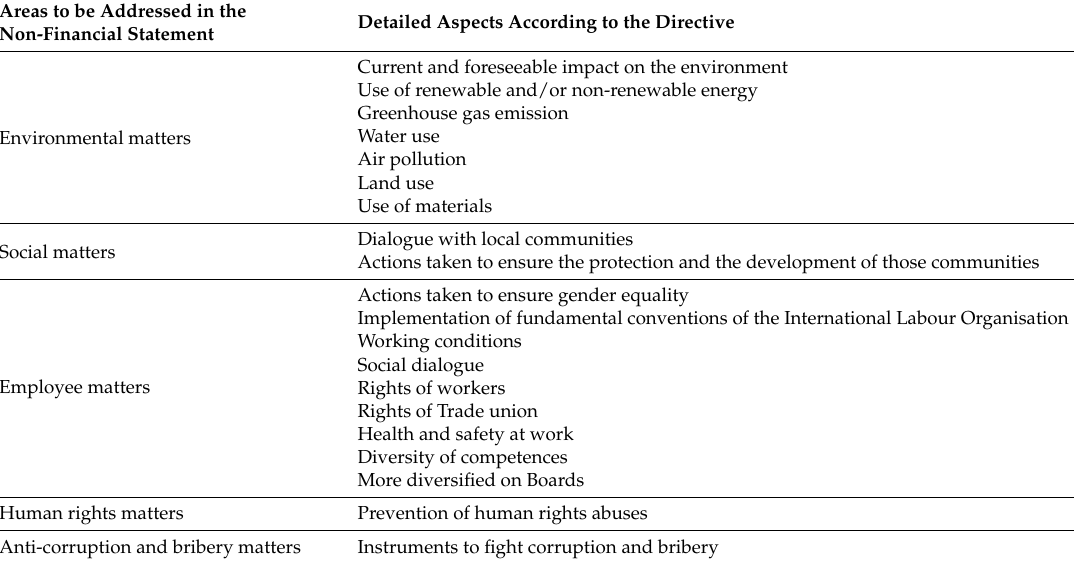
Table 1. Requirements for non-financial statements, according to Directive